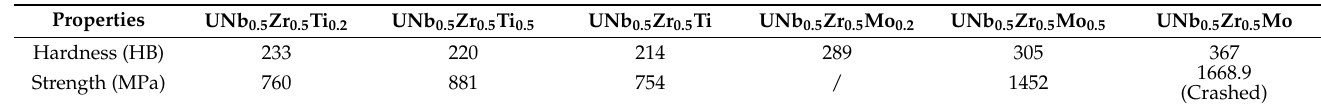
Table 7. Hardness and strength of the UNb 0.5 Zr 0.5 -X HEAs.